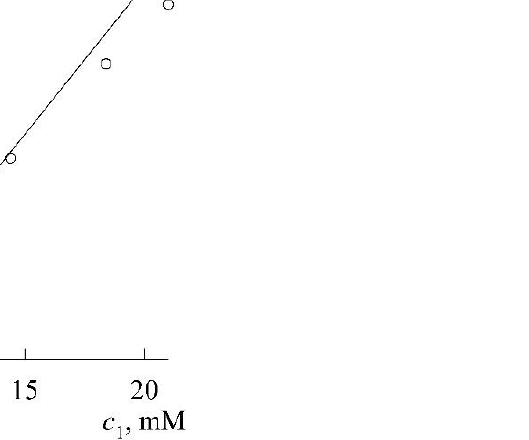
Figure 6. Calibration curve for NR in 30 mM SDS solution at the wavelength of 579 nm. Turning to the premicellar region, we do not refuse the temptation to test the value of the extinction coefficient found above to calculate the concentration of NR monomers in media with SDS below the CMC. At